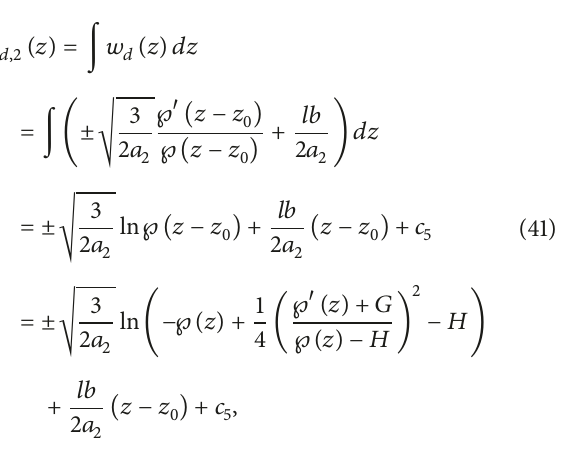
The elliptic function solutions of (3) are (𝑧) = ∫ 𝑤 (𝑧) V 𝑑,2 𝑑